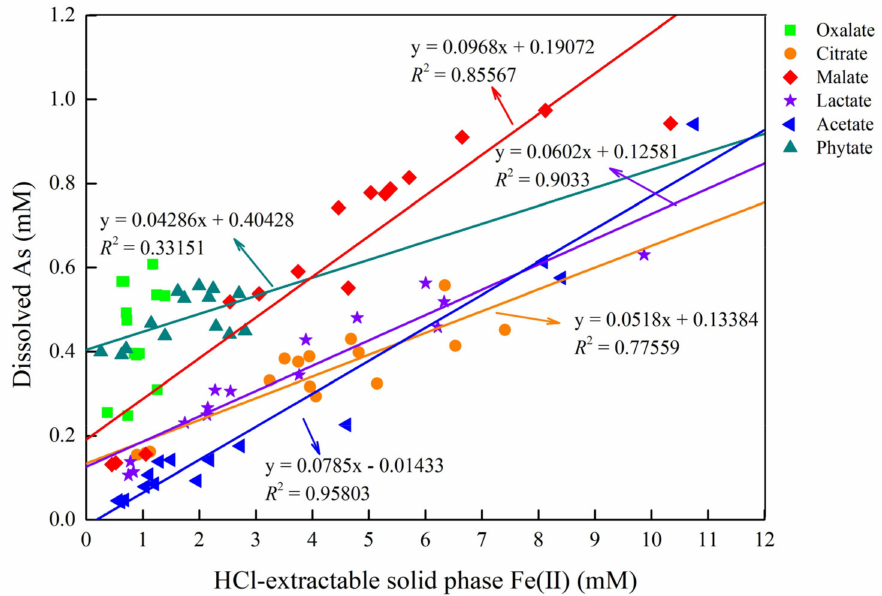
Figure 3. Relationships between dissolved As and HCl-extractable solid-phase Fe(II) for unremedi- ated soil with different LMWOAS